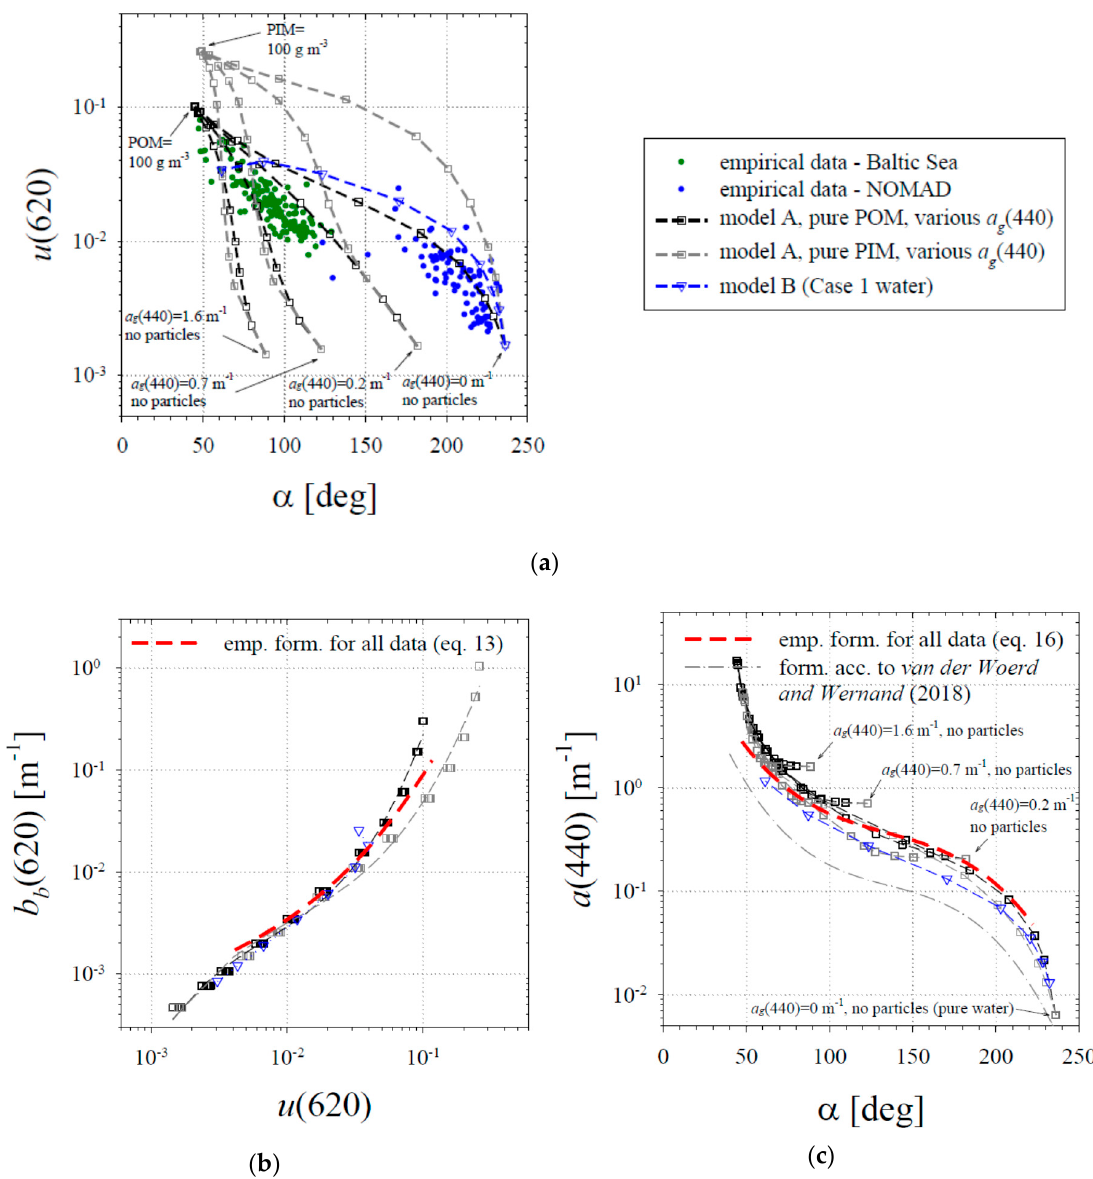
Figure 10. Comparison of empirical data and formulas with the results of simple modelling: ( a ) the relationship between the values of u (620) and the hue angle α ; ( b ) the relationship between b b (620) and u (620); ( c ) the relationship between a (440) and the hue angle α . The green and blue points in panel a represent data from the Baltic Sea and from the NOMAD database, respectively. The empirical formulas (Equations (13) and (16)) are plotted in panels b and c. Model A results were used in all panels to draw various black and grey squares connected with the dashed curves. These curves represent di ff erent scenarios in which the CDOM concentration is assumed to be constant, whereas the concentration of the pure POM or PIM fraction ranges from 0 and 100 g m − 3 . The results of model B, representing di ff erent concentrations of chlorophyll a (from 0 to 100 mg m − 3 ), were plotted in all the panels as blue triangles connected by a dashed blue line. Panel c also shows a curve representing the formula according to van der Woerd and Wernand [22].